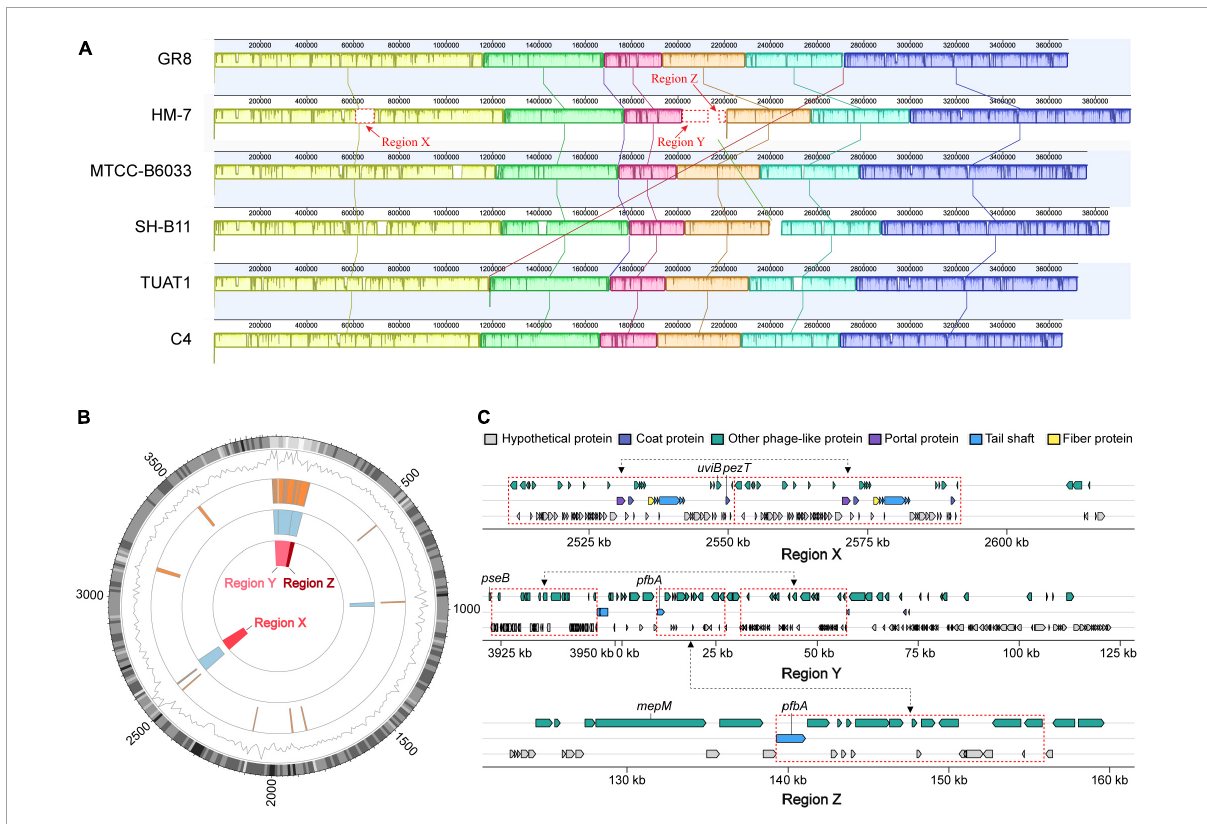
FIGURE5 Comparative analysis and mobile genetic elements in the B. pumilus strains. (A) MAUVE alignment of the genome sequences of B. pumilus MTCC-B6033, TUAT1, C4, SH-B11, HM-7 and GR-8. Boxes in the same color represent homologous regions [local colinear blocks (LCBs)] between B. pumilus genomes. Uncolored regions within the LCBs or in-between LCBs indicate the presence of specific sequences in that strain. (B) Circular genome maps showing the locations of mobile genetic elements and three unique genomic regions (X, Y, Z) in B. pumilus strain HM-7. From the inner to the outer circle: Three unique genomic regions position (red boxes); prophages position (light blue boxes); GEIs position (orange boxes); black lines and gray heatmap indicate gene density and GC content, respectively. (C) Detailed information and predicted functions of genes located in the regions of X, Y, Z. Important virulence factors were marked with gene ID. Three pairs of blocks (dashed red) linked with black arrows represent repeat fragments.